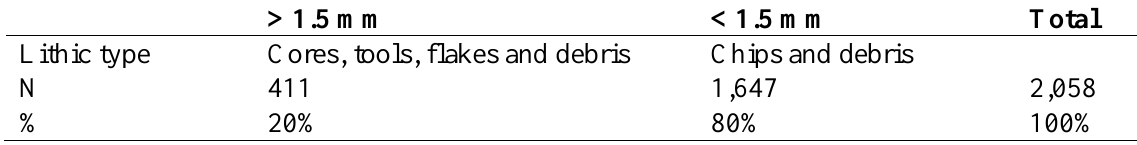
Table 1. Assemblage composition classified by size